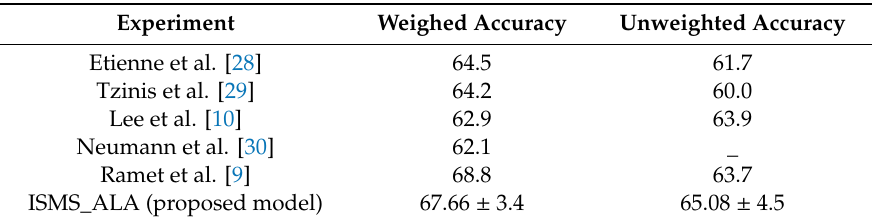
Table 4. Comparison of performance with other studies.